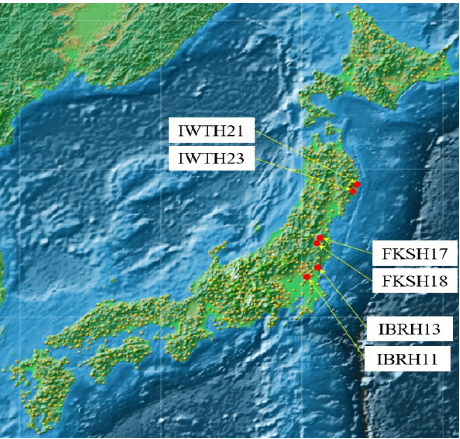
Figure 1. Six stations selected